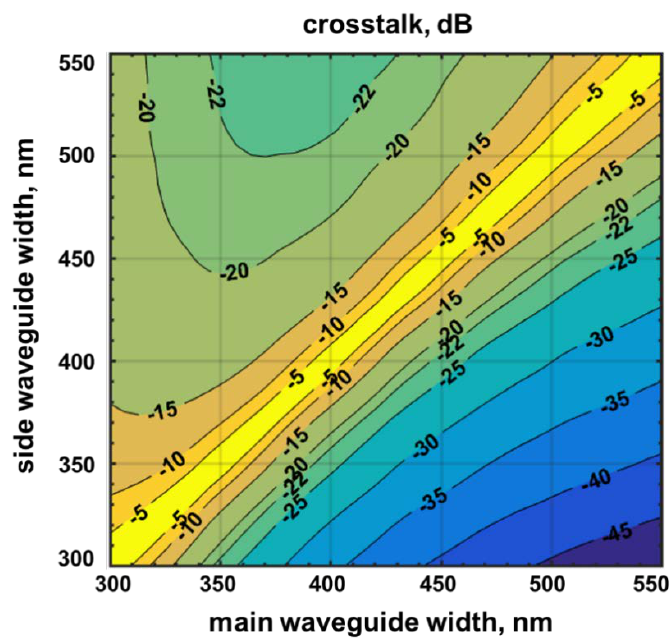
Figure 2. Simulation results of the crosstalk from main to side waveguide with varying widths.